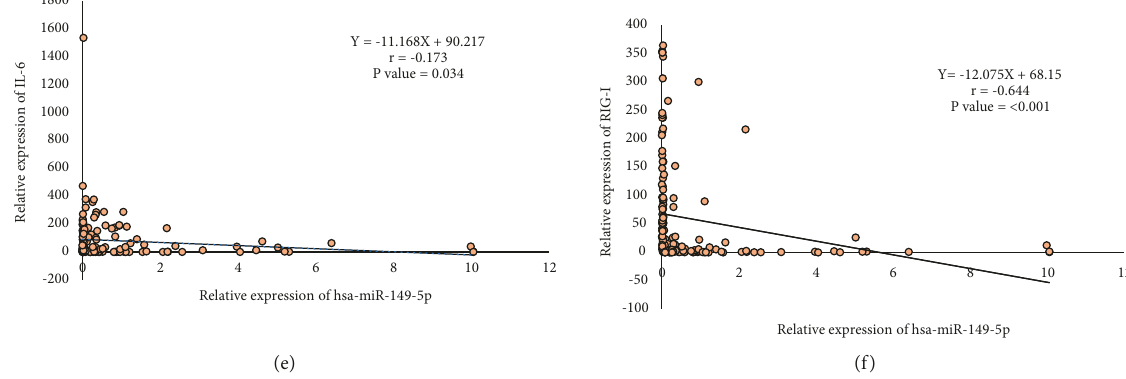
Figure 2: (a) The heatmap analysis. (b) The negative correlation between hsa_circ_0000479 and hsa-miR-149-5p expression levels in COVID-19 ( r �− 0.165, P value � 0.043). (c) The positive correlation between hsa_circ_0000479 and IL-6 expression levels in COVID-19 ( r � 0.631, P value � ˂ 0.001). (d) The positive correlation between hsa_circ_0000479 and RIG-I expression levels in COVID-19 ( r � 0.451, P value � ˂ 0.001). (e) The negative correlation between hsa-miR-149-5p and IL-6 expression levels in COVID-19 ( r � − 0.173, P value � 0.034). (f) The negative correlation between hsa-miR-149-5p and RIG-I expression levels in COVID-19 ( r � − 0.644, P value � ˂